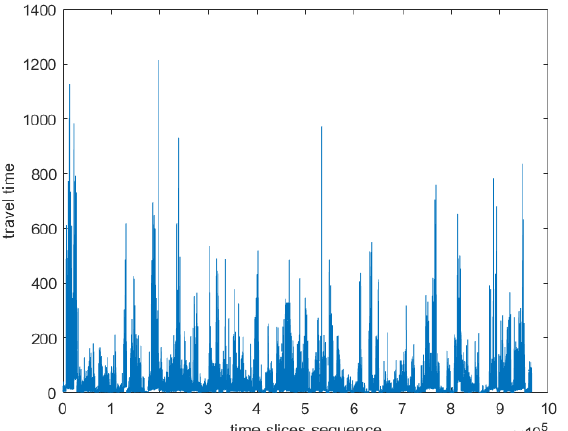
Figure 5. Data distribution.